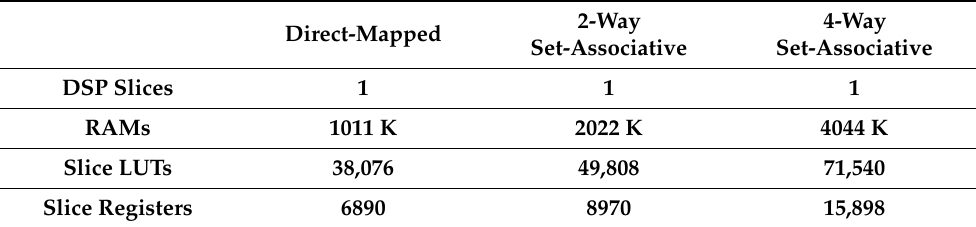
Table 8. Resource utilization